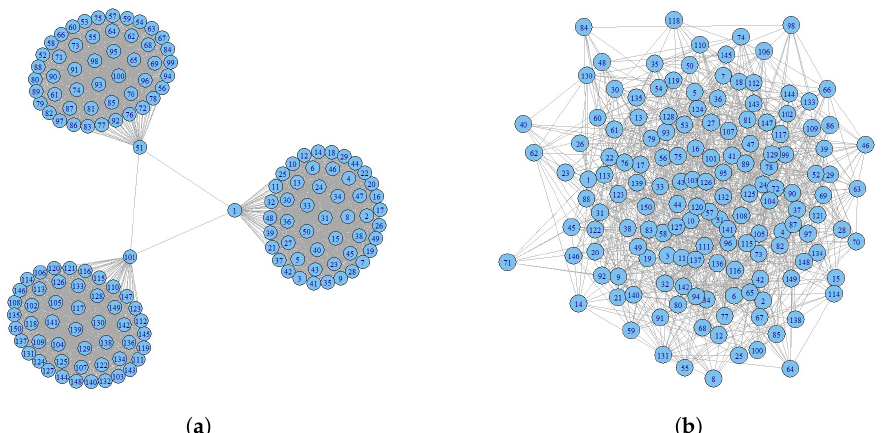
Figure 7. Topological structure of the first and second company. ( a ) Network of the first company. ( b ) Network of the second